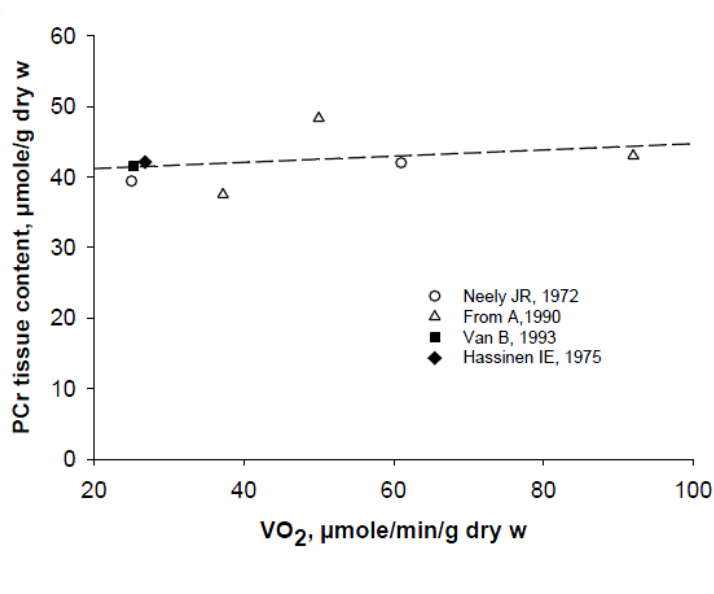
Figure 6. Four principal characteristics of heart energy metabolism. (A) Summary of data from different laboratories on metabolic homeostasis in heart cells. Very similar stable average intracellular PCr concentrations corresponding to different increasing respiration rates are always observed. (B) shows oscillations of relative PCr content during cardiac cycle in perfused rat’s heart under conditions of metabolic stability. The curve marked by empty circles ( ○ ) is refitted using experimental data received by Honda et al ., 2002 in gate- pacing in [165] (with permission), only the mean values of metabolites are shown. (C) The origin of the problem of the compartmentalization of adenine nucleotides and metabolic energy sensing in cardiac cells. The data show metabolic changes in the totally ischemic dog hearts. Data are redrawn from [10] (with permission). (D) Peak systolic pressure P of isolated isometric hypoxic rat hearts is independent from free energy of ATP hydrolysis, dG/d ξ calculated from creatine kinase equilibrium and total tissue contents of creatine, phosphocreatine and ATP. Reproduced from [167] with